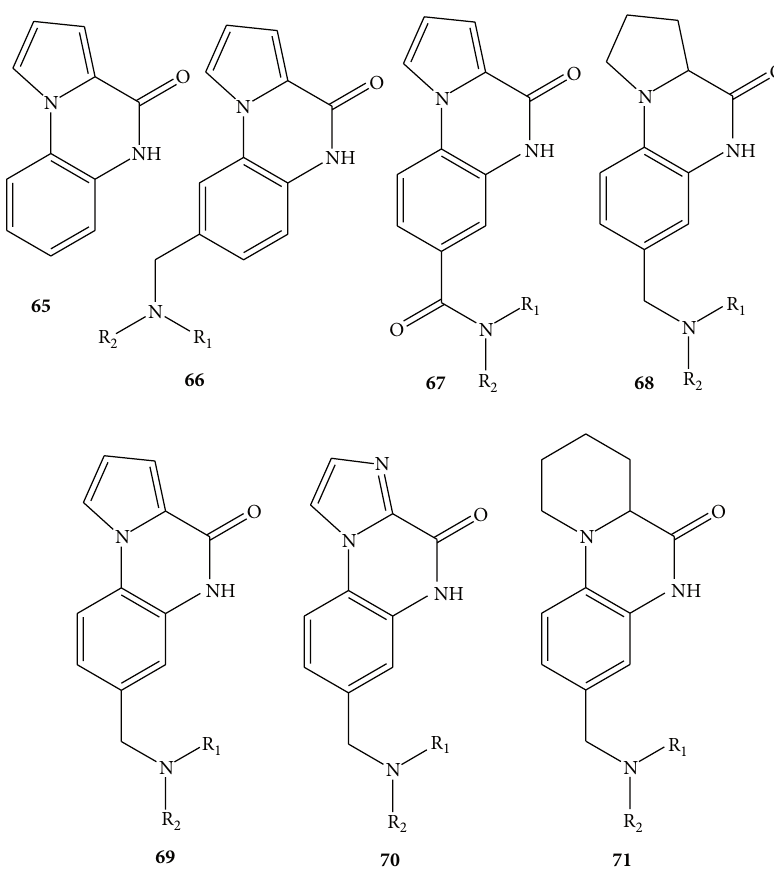
Figure 28: Chemical structures of compounds 65–71